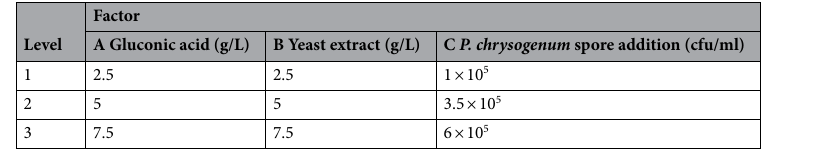
Table 6. Orthogonal test level.